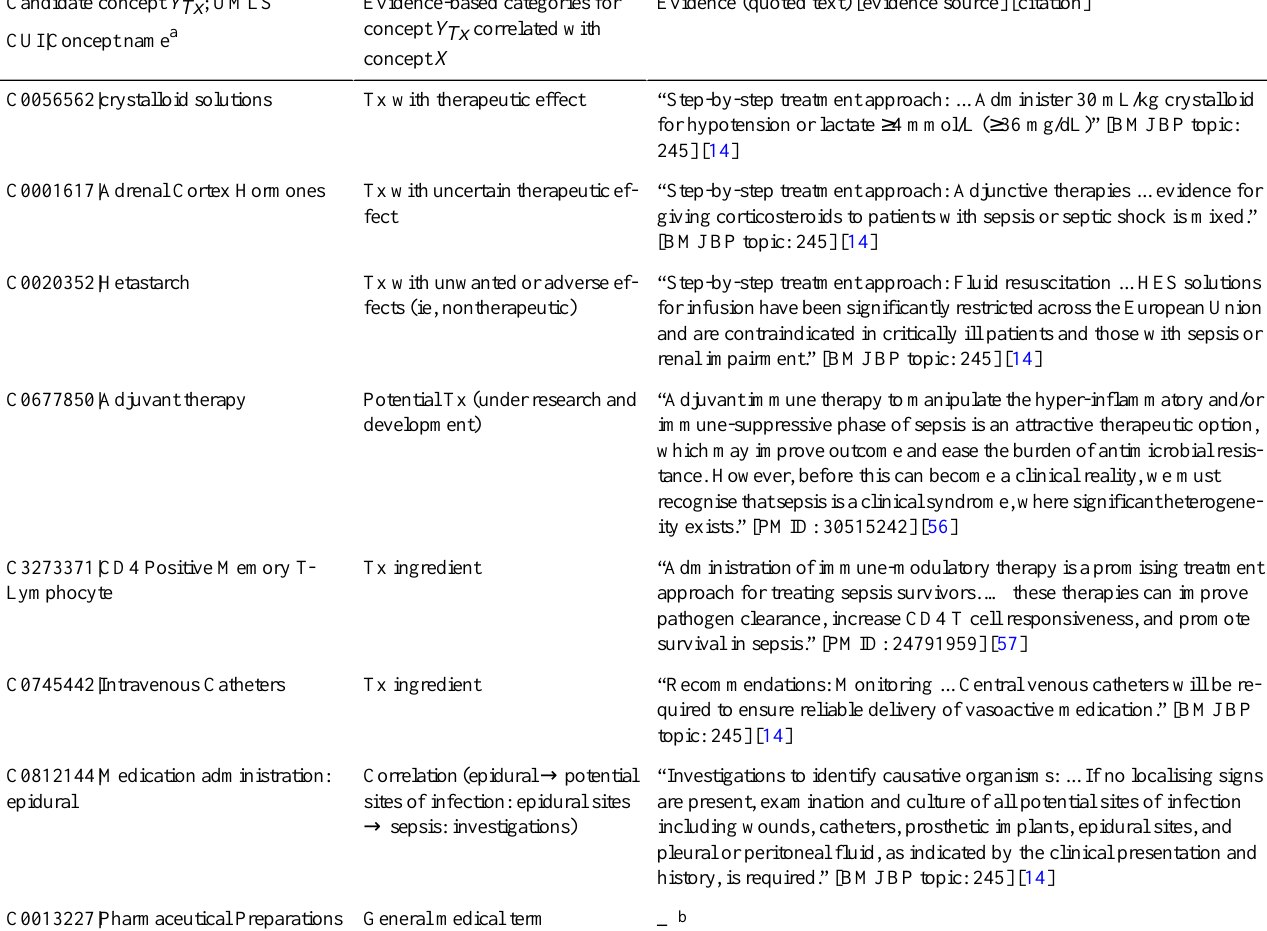
Table 1. Evidence from the literature searches, that is quoted text and reference, for unified medical language system Metathesaurus concept pairs (X, Y Tx ) with